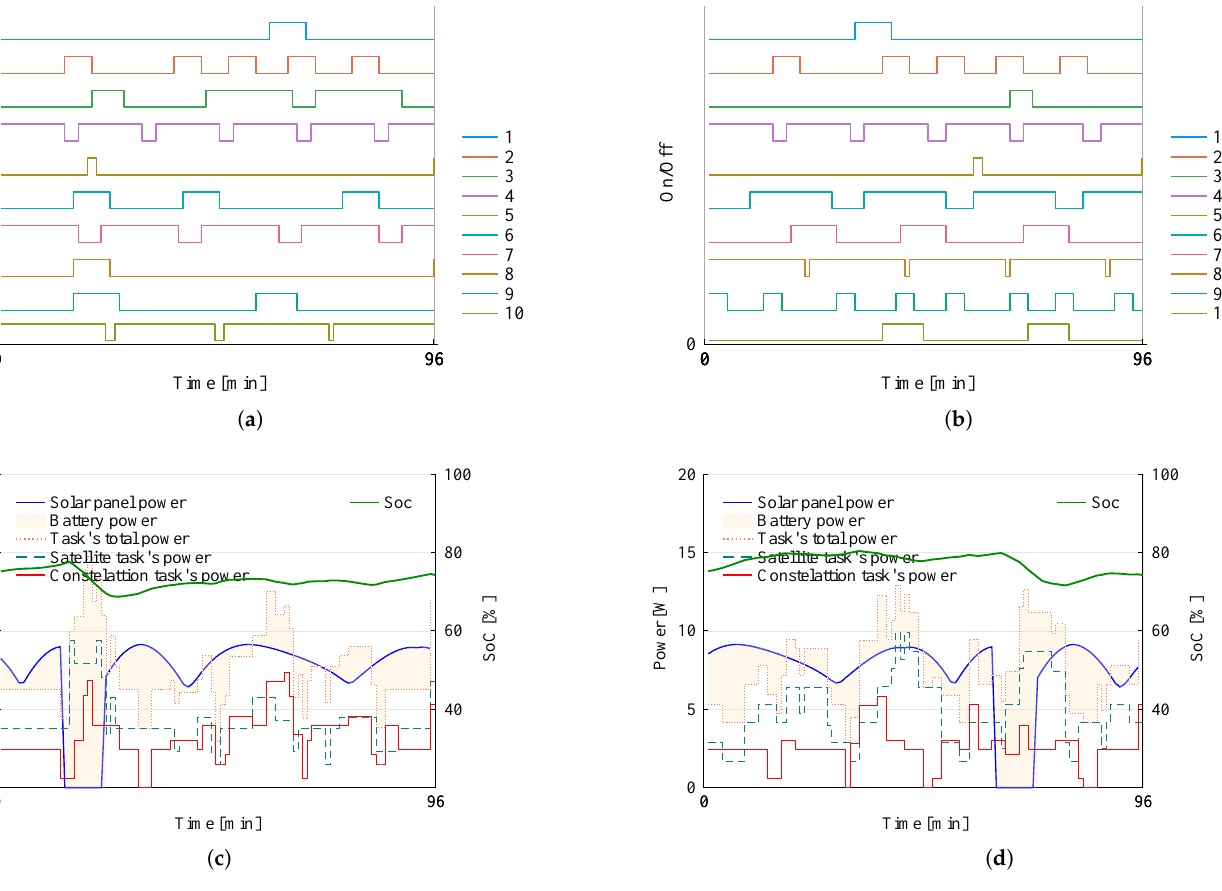
Figure 3. Mission planning for a two-satellite constellation. ( a ) Scheduling for satellite 1. ( b ) Schedul- ing for satellite 2. ( c ) Energy analysis for satellite 1. ( d ) Energy analysis for satellite